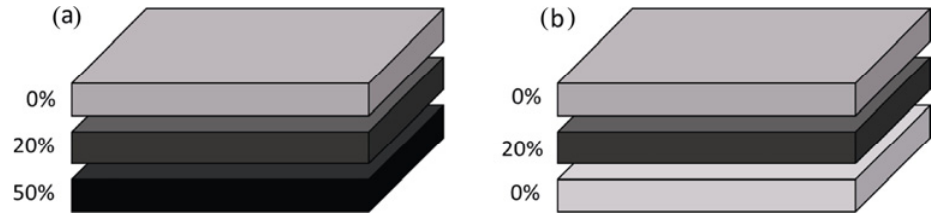
Fig. 10 Possible morphologies of graded samples: (a) L1, 0–20–50 wt% carbon fibres; (b) L2, 0–20–0 wt% carbon